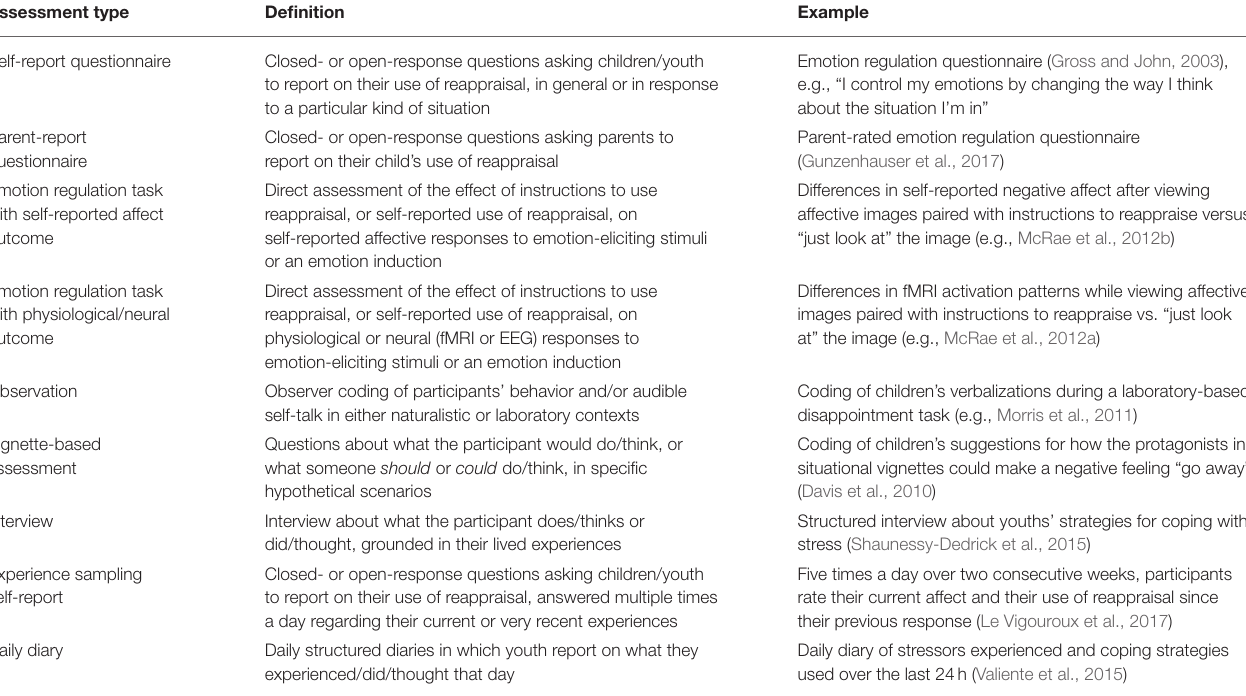
TABLE 1 | Coding categories for reappraisal assessment